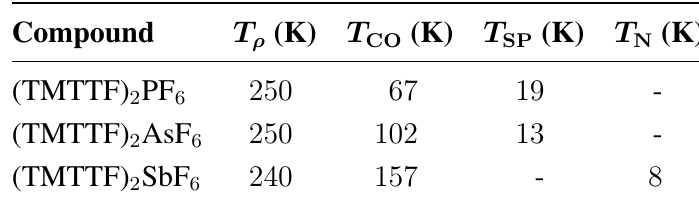
Table 1. Transition temperatures for charge localization T Fabre salts (TMTTF) temperature of the antiferromagnetic ordering, determined by transport and magnetization measurements